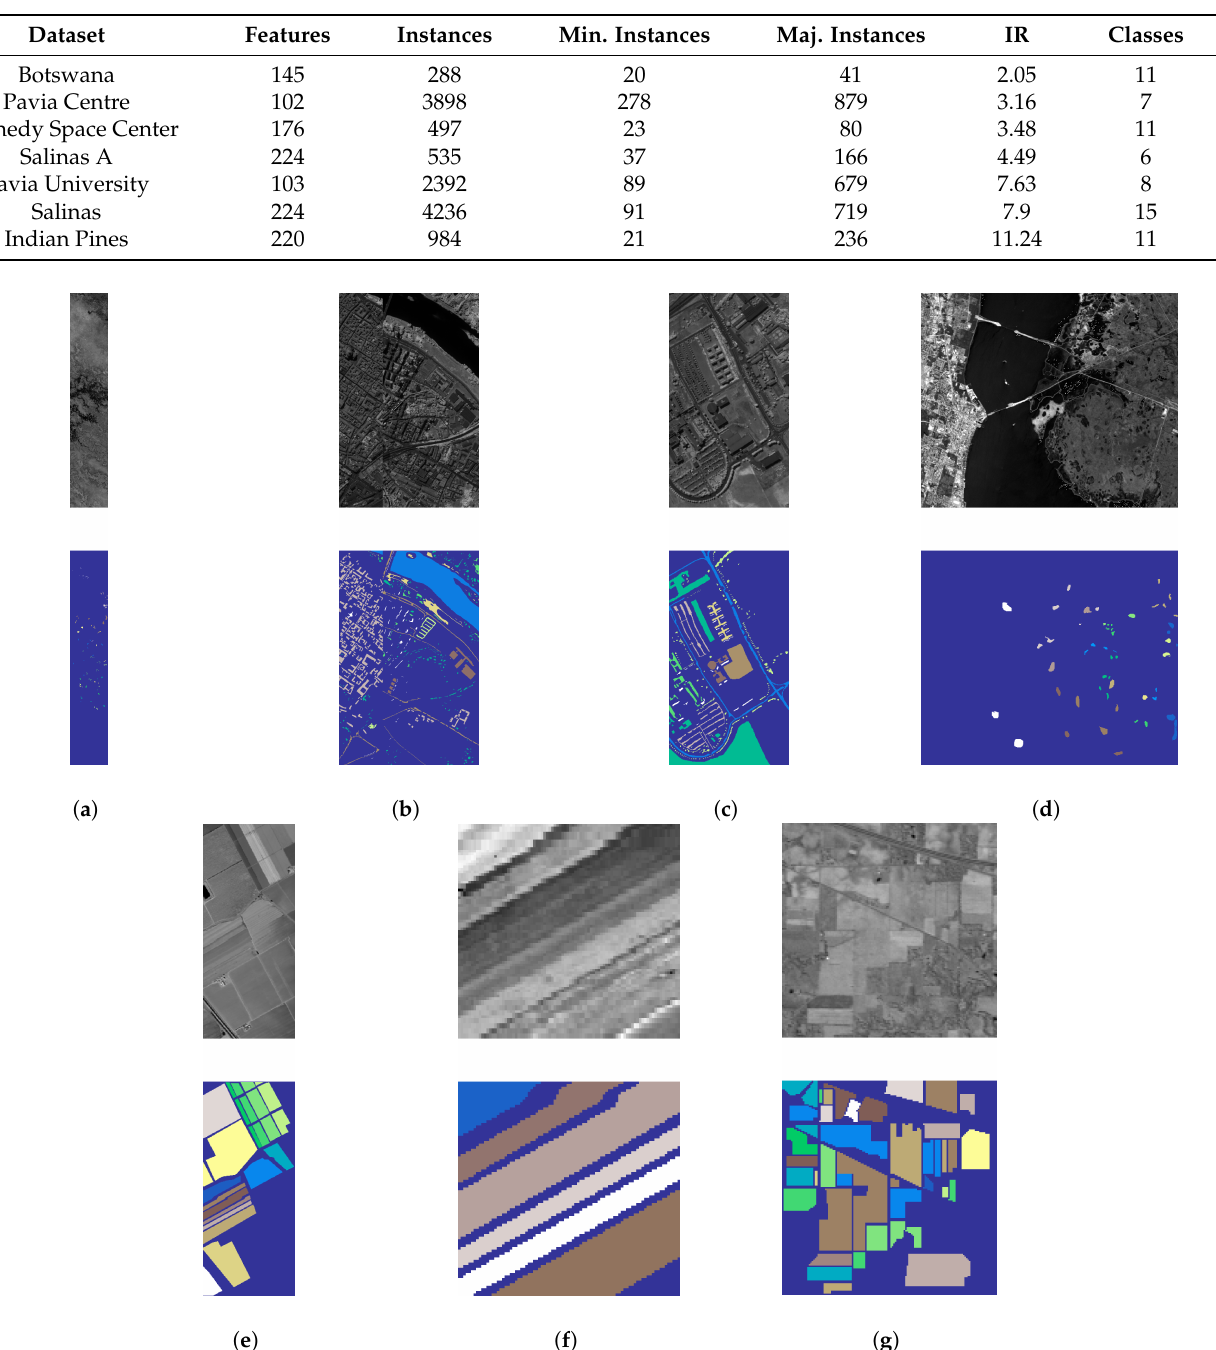
Figure 5. Gray scale visualization of a band (top row) and ground truth (bottom row) of each scene used in this